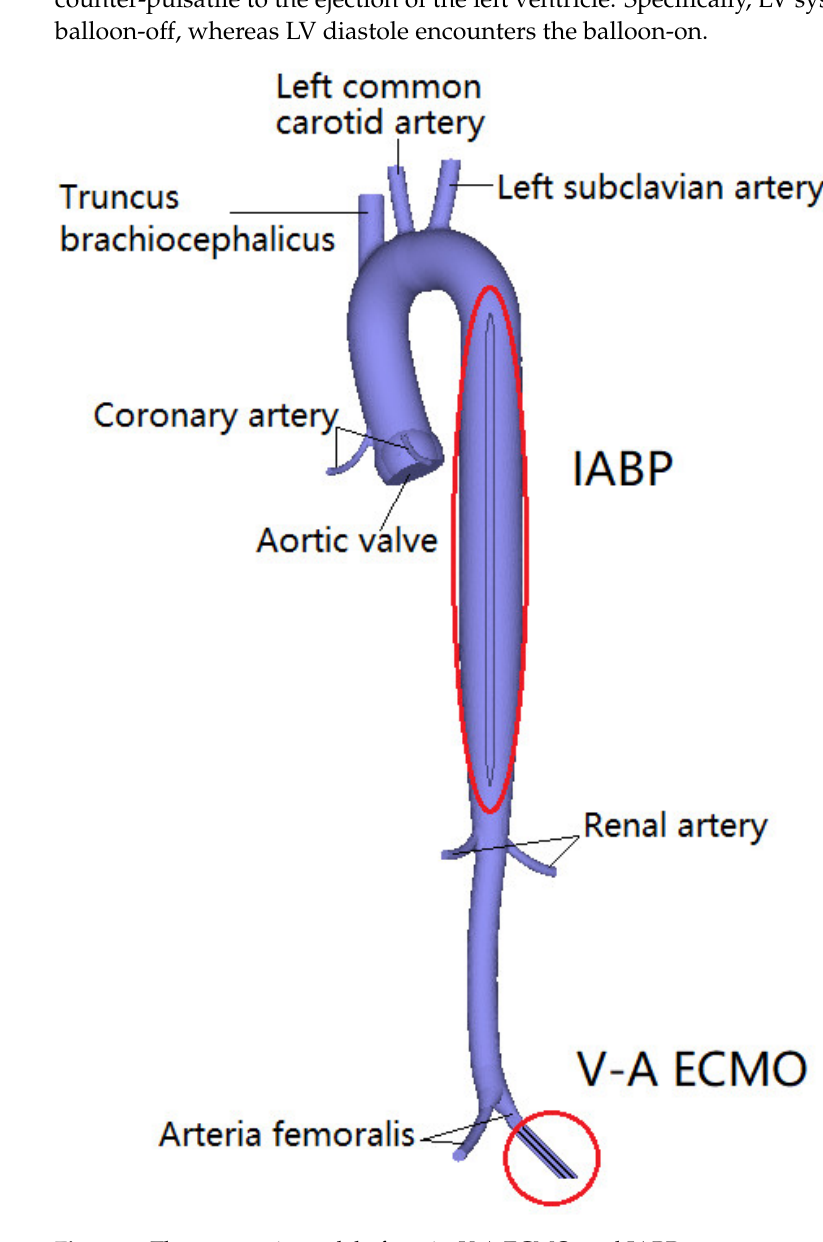
Figure 1. The geometric model of aortic, V-A ECMO, and IABP.